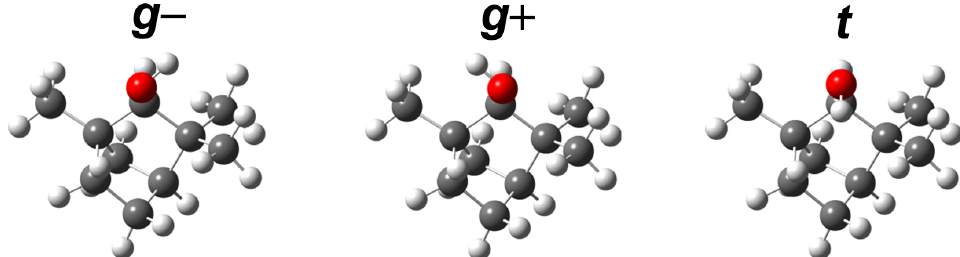
Figure 2. Optimized torsional conformers of ( + )- α -fenchol at B3LYP-D3(BJ)/may-cc-pVTZ level. They are labeled according to the qualitative arrangement of the HOC α H dihedral: gauche ( g ) ≈ − 60° or + 60°, or trans ( t ) ≈ ±